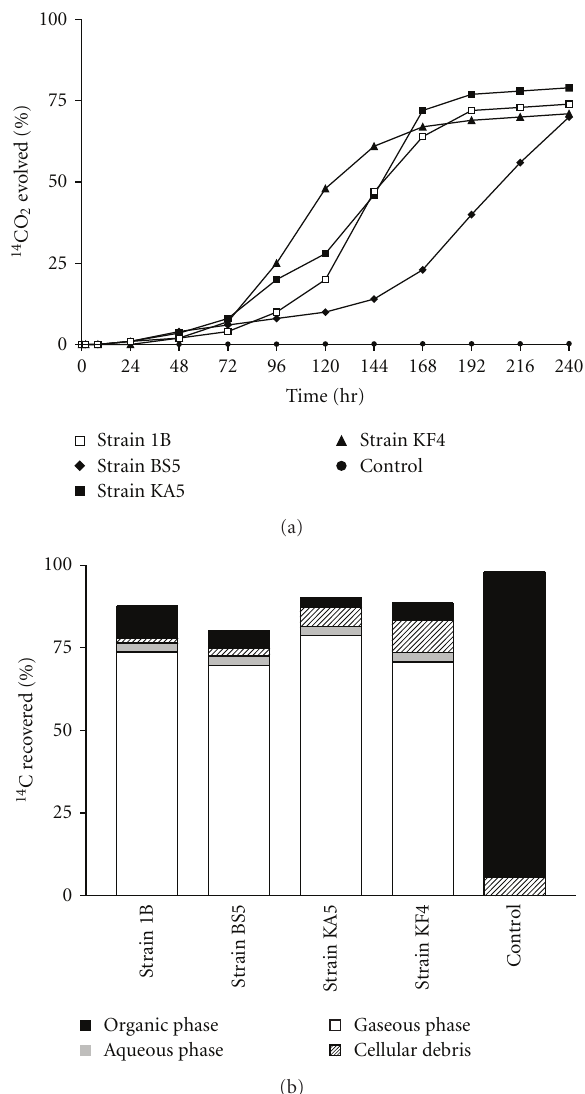
Figure 2: Pyrene mineralisation (a) by Mycobacterium sp. strains 1B (white square), BS5 (black diamond), KA5, (black square), KF4 (black triangle), and mercuric chloride killed controls (black circle). The distribution of 14 C in the organic phase (undegraded pyrene: black square), aqueous phase (water soluble metabolites: Gray square), gaseous phase ( 14 CO 2 : white square), and cellular debris (dashed square) at the completion of mineralisation experiments is also shown